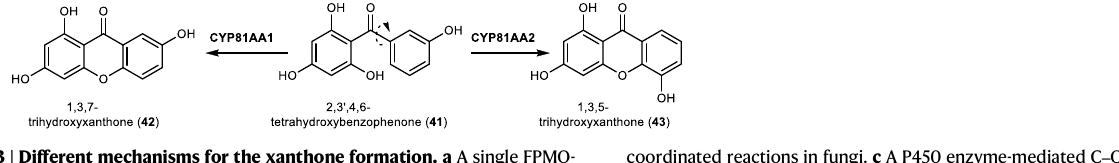
Fig. 3 | Different mechanisms for the xanthone formation. a A single FPMO- catalyzed multiple oxidations in actinomycetes. b A reductase and a dioxygenase-